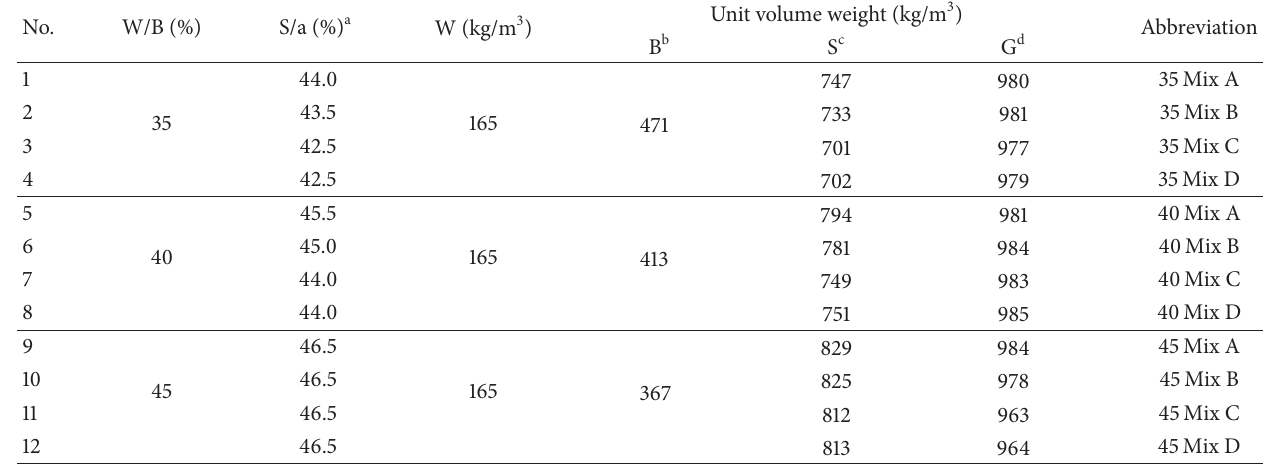
Table 4: Design of concrete